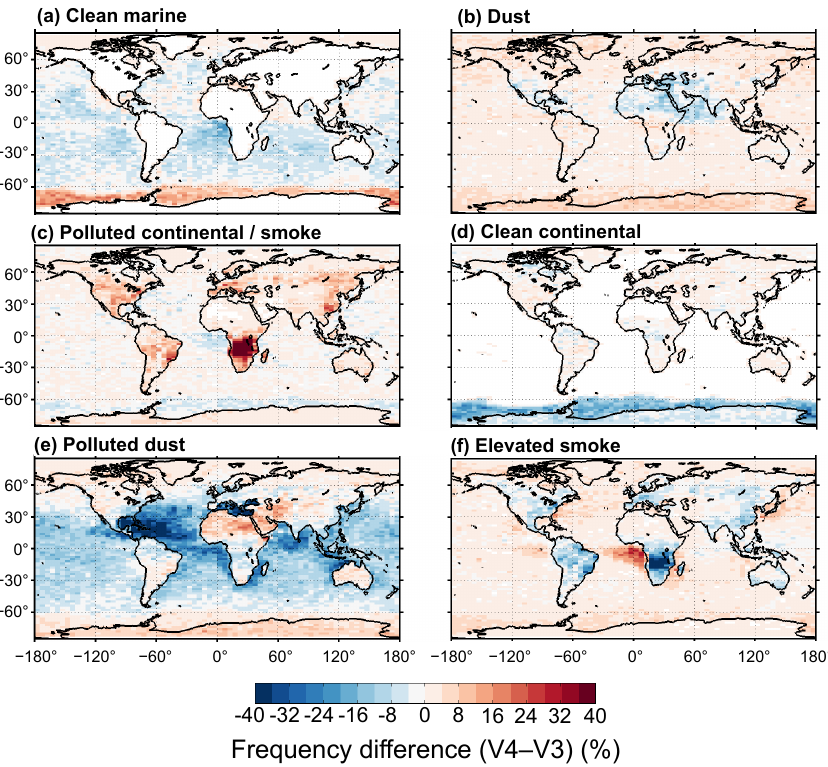
Figure 11. Differences in frequency of occurrence of indicated aerosol subtype from V3 to V4 (fV4 – fV3) for aerosol subtypes common to both versions, JJA 2007 day and night. Frequencies are computed from level 2 aerosol profile products and the number of aerosol samples, with the indicated aerosol type divided by the total number of aerosol